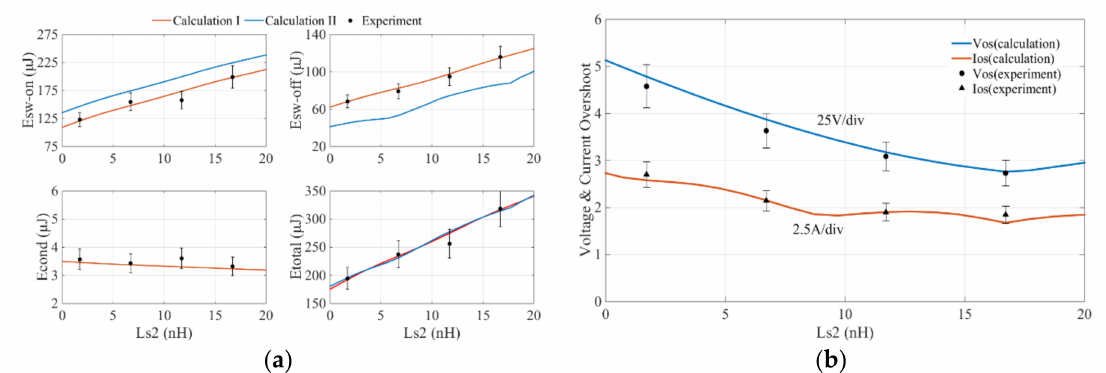
Figure 15. Comparison between experiment and calculation under the influence of common source stray inductance L s2 . ( a ) Power losses. ( b ) Voltage overshoot and current overshoot.